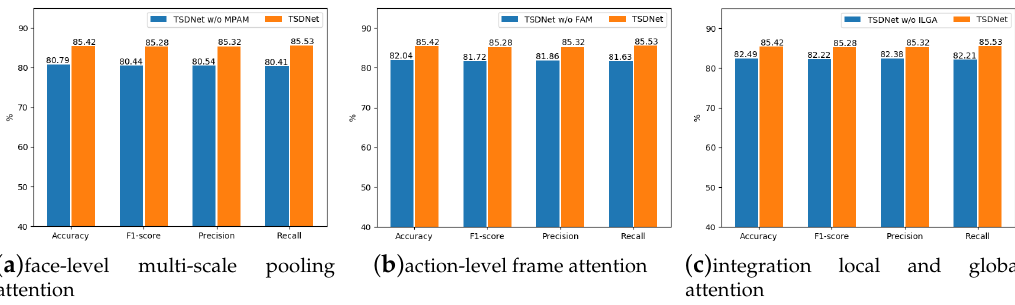
Figure 5. Effectiveness of attention mechanisms in TSDNet.